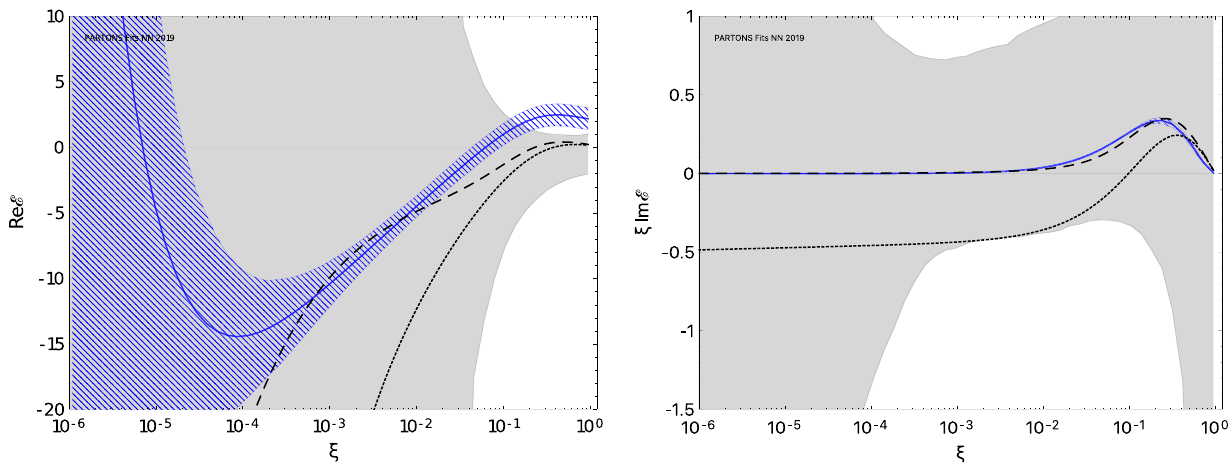
Fig. 18 Real (left) and imaginary (right) parts of the CFF E as a function of ξ for t = − 0 . 3 GeV 2 and Q 2 = 2 GeV 2 . For further description see the caption of Fig. 16